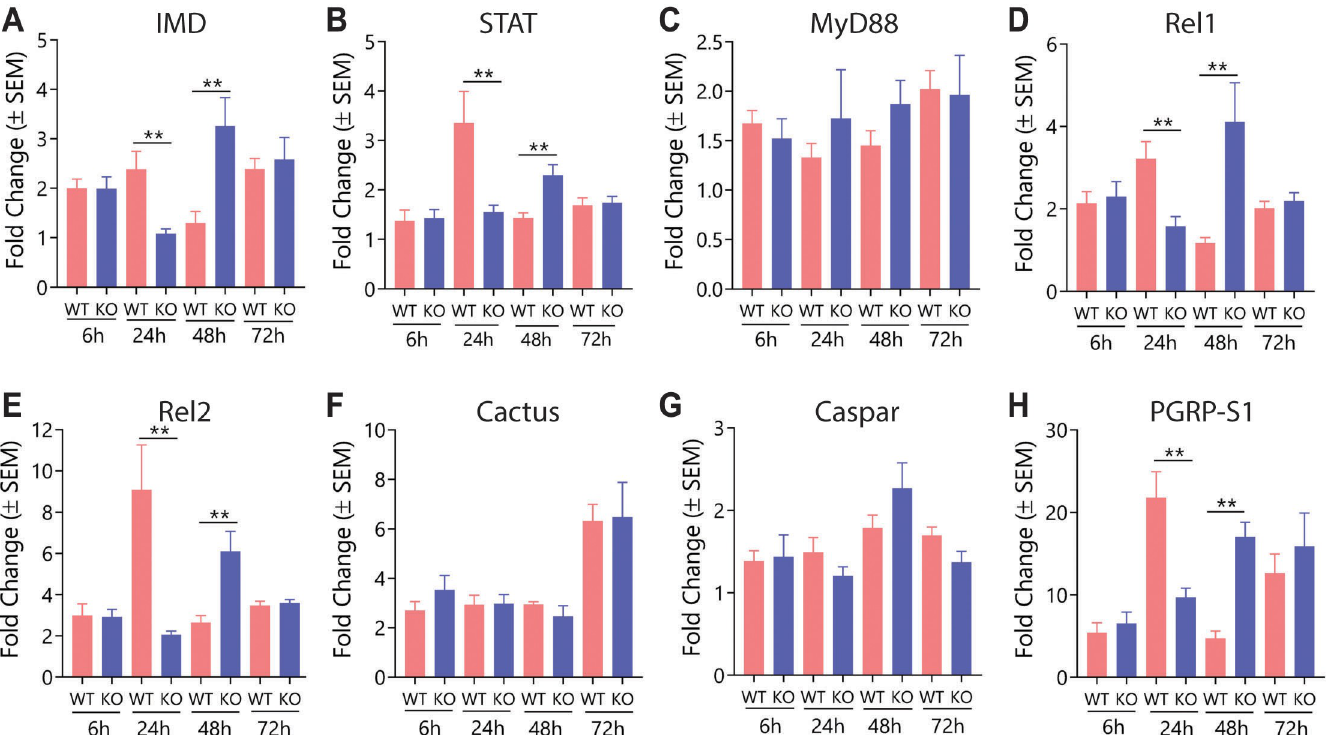
Fig 9. Effect of mJHBP deficiency on the expression of Toll , IMD , and JAK/STAT pathway components in response to bacterial challenge. Gene expression comparison between WT and KO females for: A. IMD ( IMD Pathway); B. STAT ( JAK/STAT pathway), C. MyD88 ( Toll pathway), D. Rel1 (Toll pathway), E. Rel2 ( IMD pathway), F. Cactus ( Toll pathway), G. Caspar ( IMD pathway), H. PGRP-S1 . Fat bodies of infected WT and KO mosquitoes were dissected at 6, 24, 48, and 72 h post- infection. Each time point represents 50 mosquitoes (5 biological replicates of 10 mosquitoes each). Significance levels (Mann-Whitney) are indicated with asterisks (p �� �